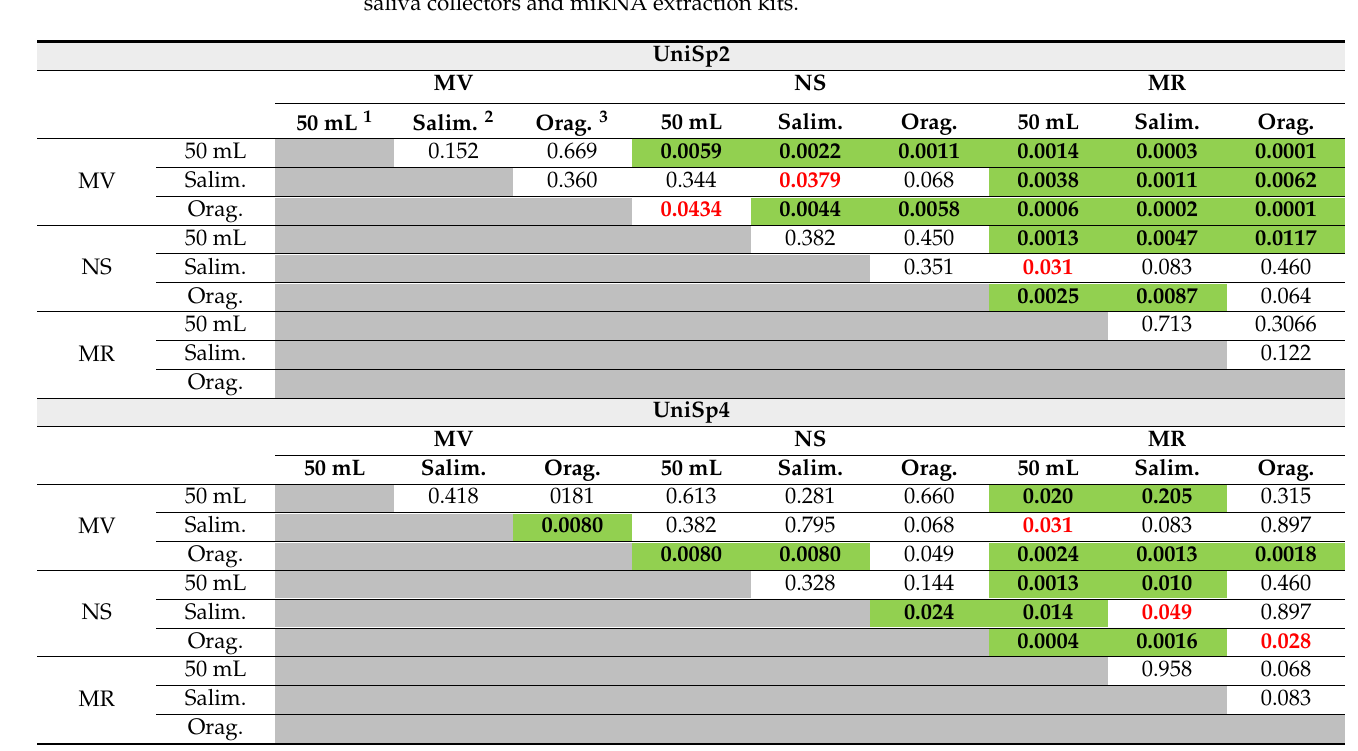
Table 2. Comparison of the Cq values of Spike-in 2, 4 and 5 obtained by the different combinations of saliva collectors and miRNA extraction